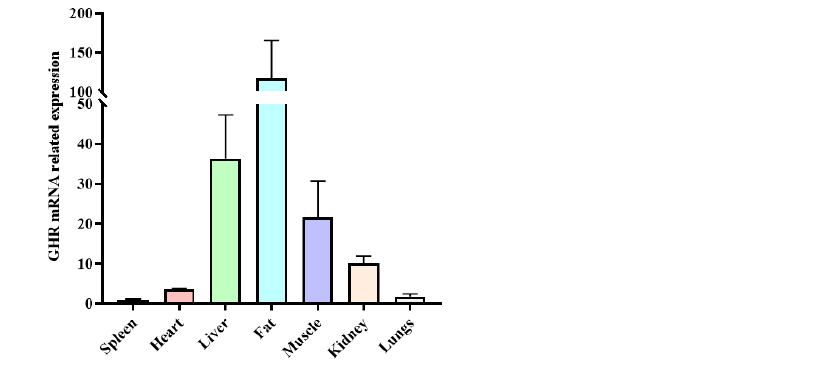
Figure 4. The expression level of GHR gene mRNA in different tissues of yak.